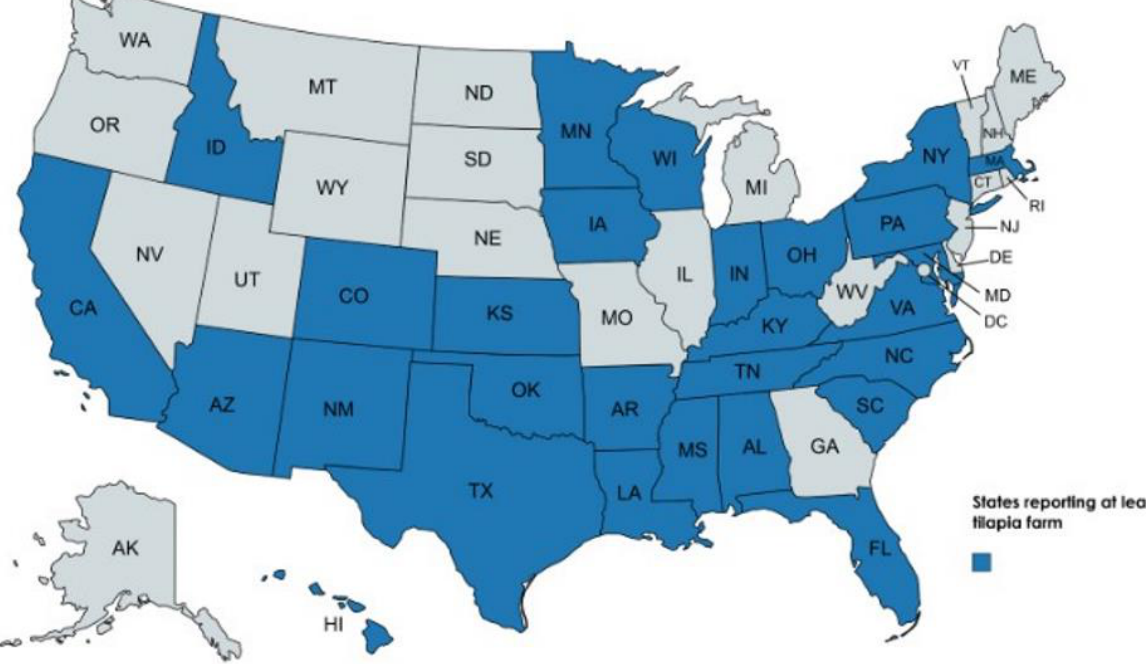
Figure 1. U.S. states reporting at least one tilapia farm in 2018. SOURCE: 2018 Census of Aquaculture (USDA-NASS